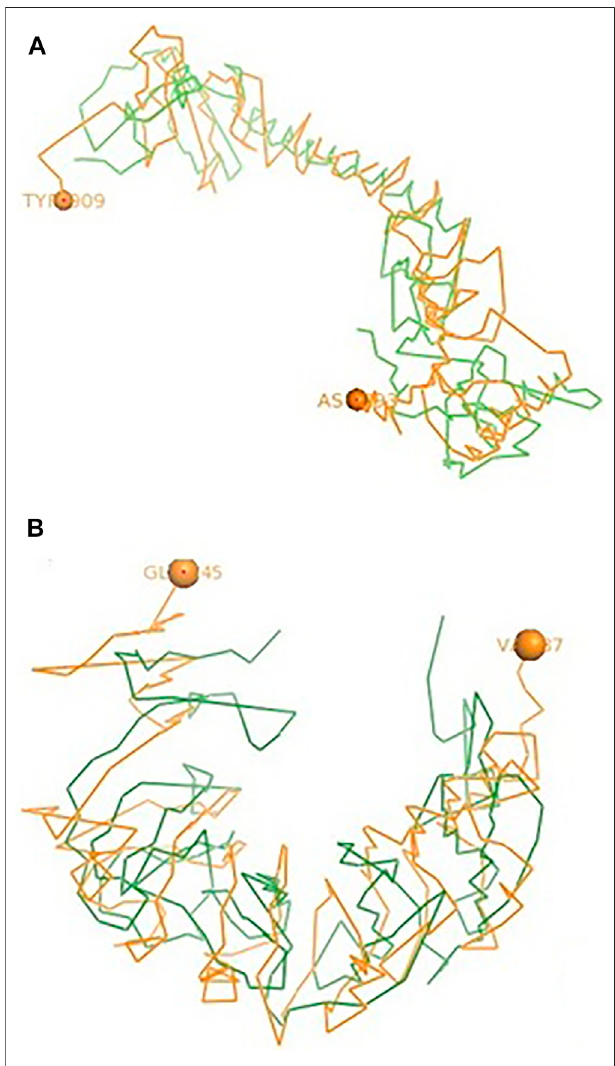
FIGURE 7 | (A) Molecular docking TLR7 of duck with H antigen of avian in fl uenza. (B) Molecular docking TLR7 of duck with NS antigen of avian in fl